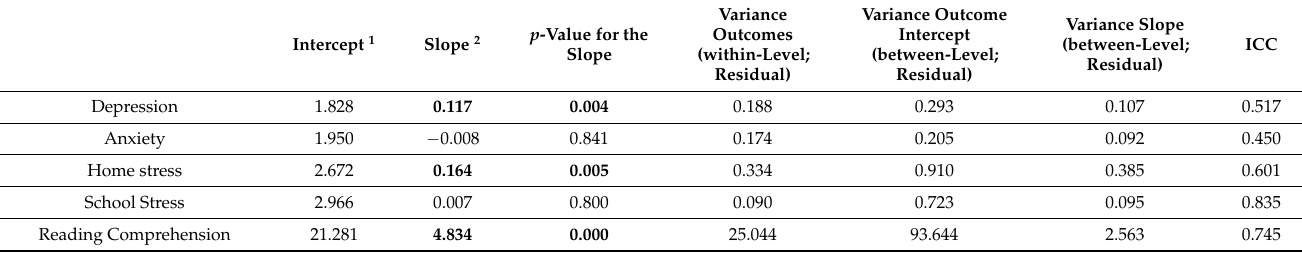
Table 1. Slopes of outcomes regressed on the binary measurement timepoint (models of first step). Intercept 1 Slope 2